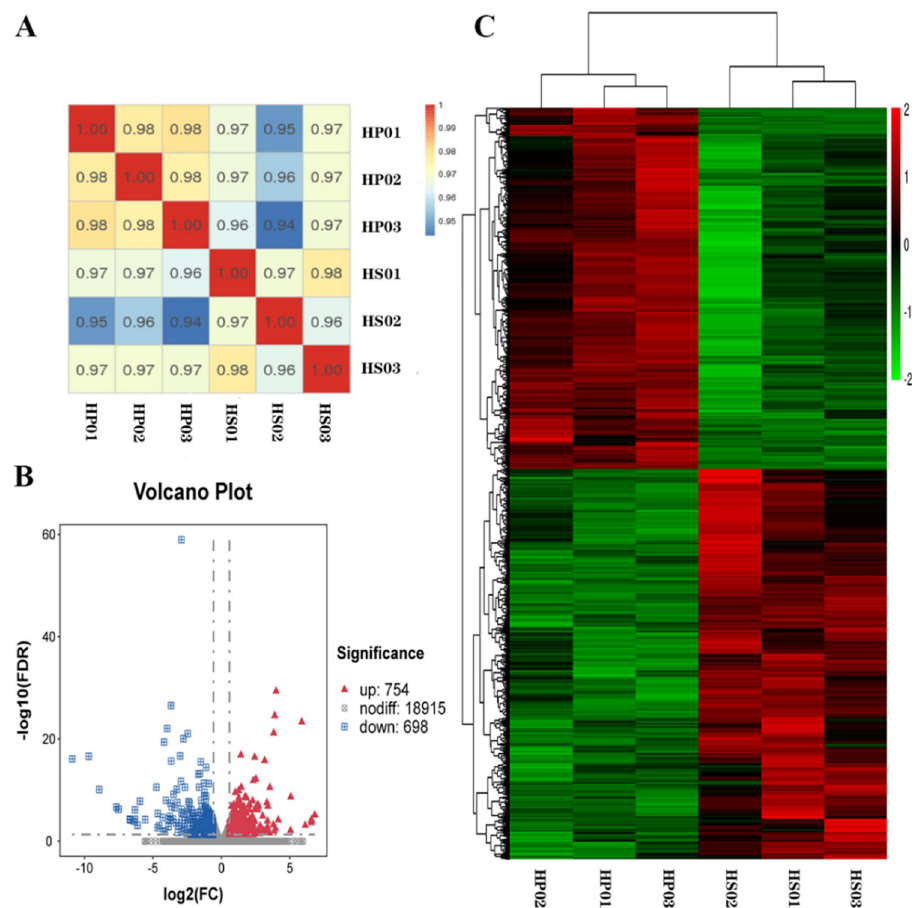
Fig 3. Preliminary analysis of the gene expression. ( A ) Heat map of gene expression correlation between samples. ( B ) Volcano plot of DEG screening. ( C ) Hierarchical clustering heat map of DEGs.